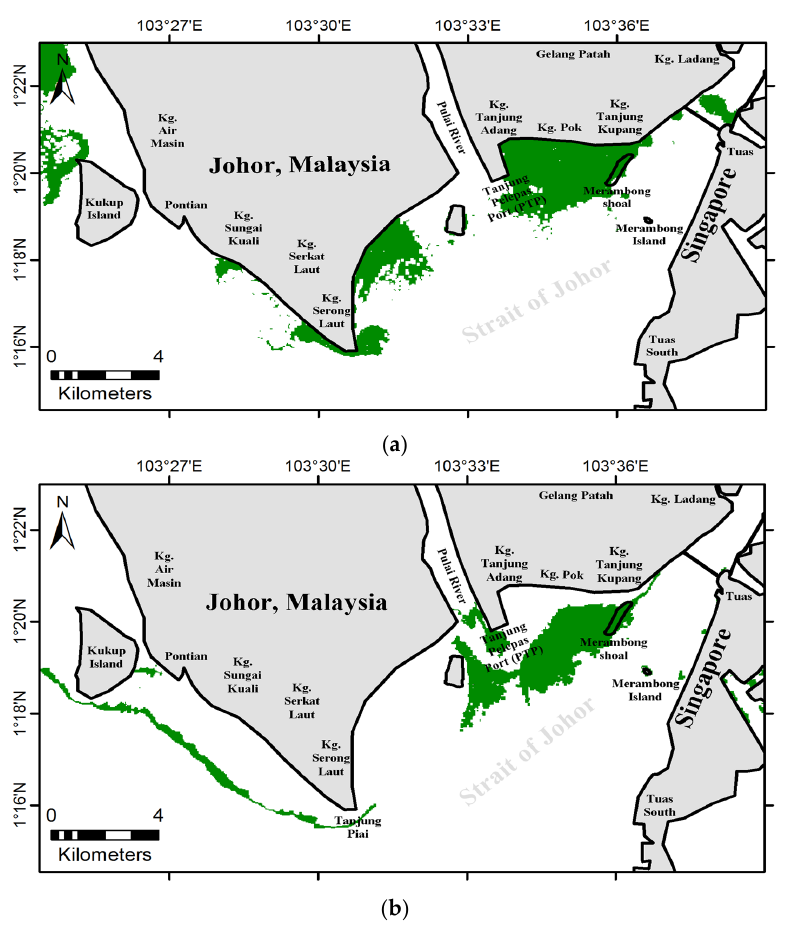
Figure 7. Submerged seagrass occurrence (green shaded areas) at the Straits of Johor in ( a ) 2009 and ( b ) 2013. Table 7. Summary of submerged seagrass area by MLC.